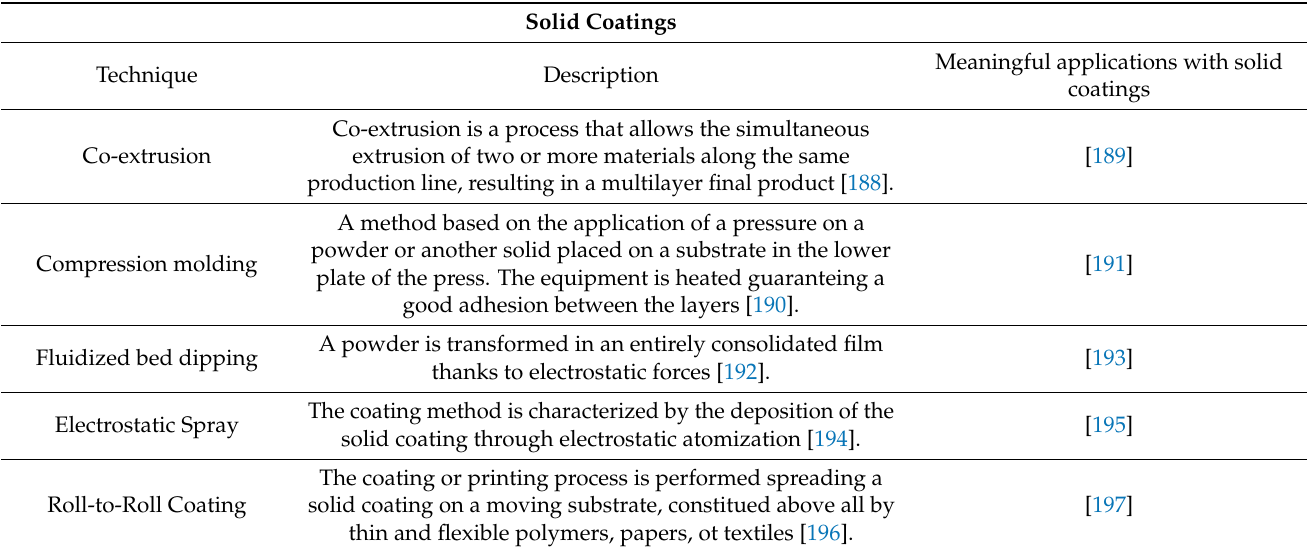
Table 3. Description of solid coatings application techniques and main results on solid